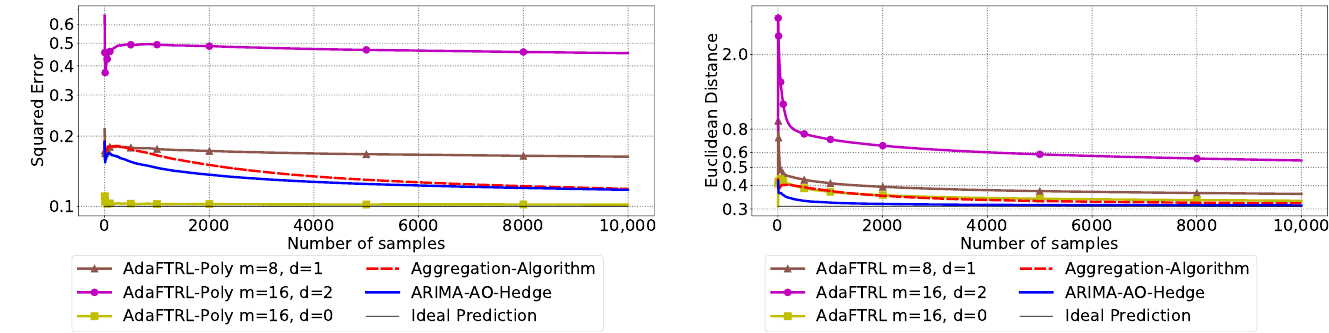
Figure 7. Model selection in setting 1.